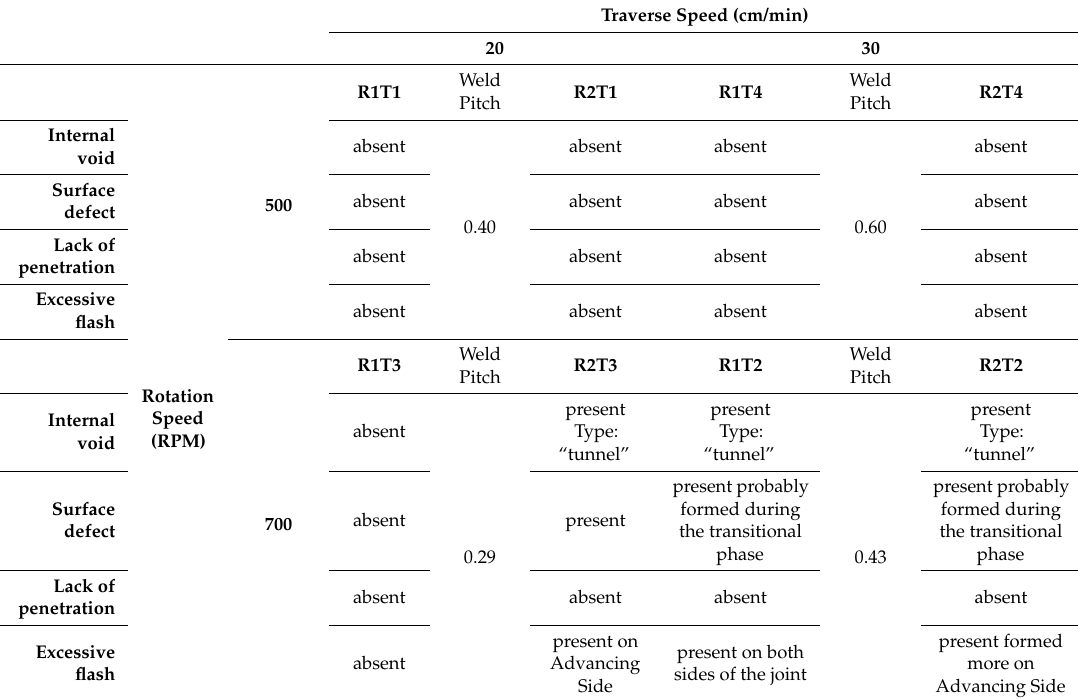
Table 3. Summary of results obtained by the visual